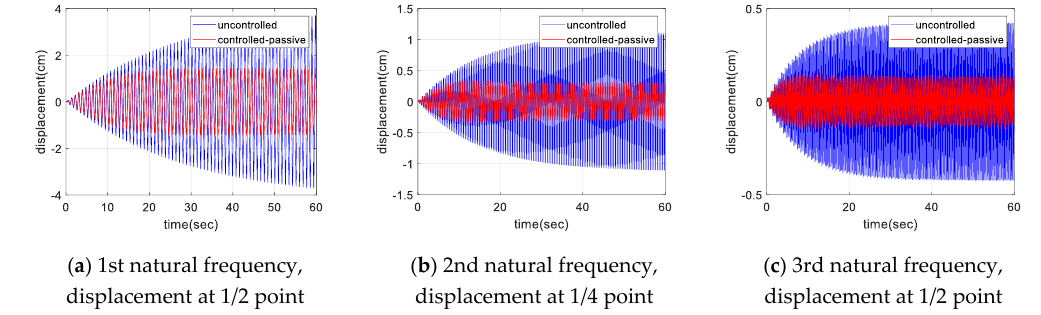
Figure 10. Displacement response of the cable for sinusoidal input. Sensors 2017 , 17 , 2499